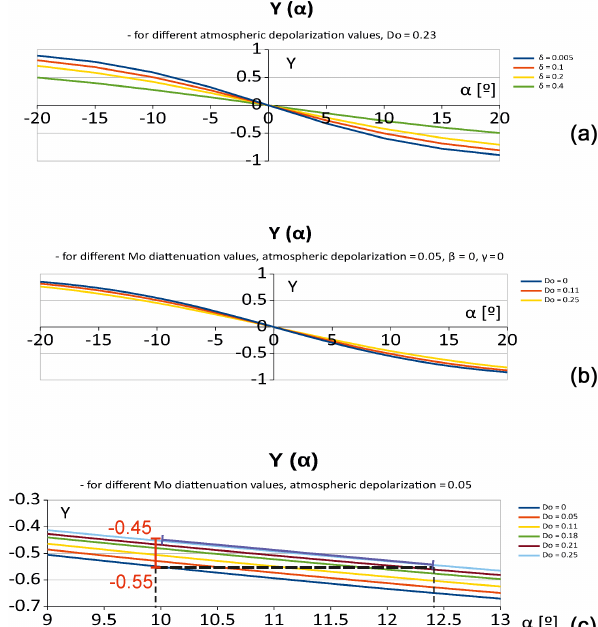
Figure 4. Numerical simulation: (a) calibrated signal ratio vs. α simulations for different atmospheric depolarization values – α (0 ◦ :180 ◦ ); (b) calibrated signal ratio vs. α simulations for dif- ferent atmospheric depolarization values – α (0 ◦ :10 ◦ ); (c) η – α simulations for different atmospheric depolarization values.